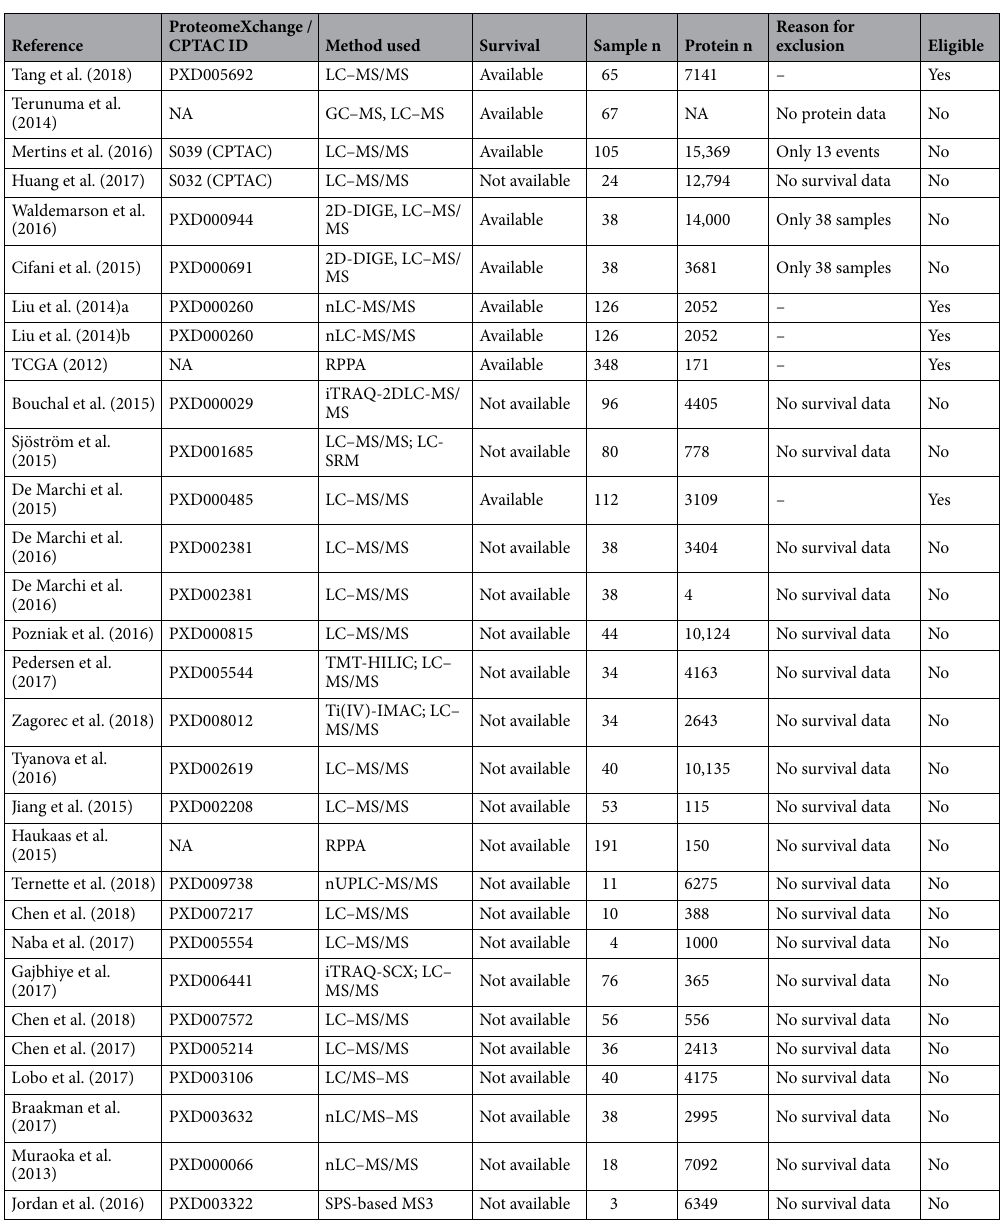
Table 1. Overview of breast cancer proteomic